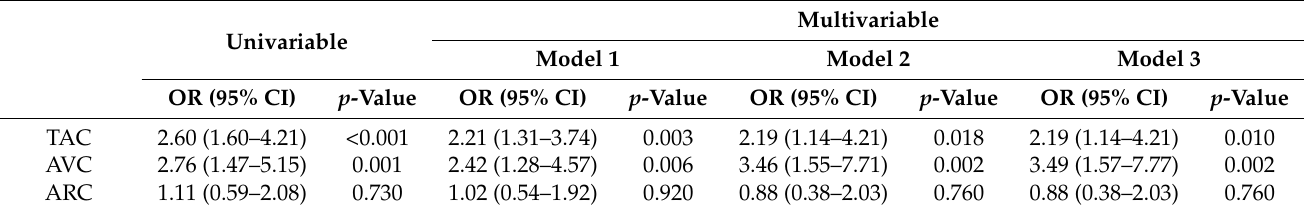
Table 5. Multivariable logistic regression analyses for the relationship of aortic valve, aortic root, thoracic aorta calcium, and atrial fibrillation in 4962 participants (CACS ≥ 100).